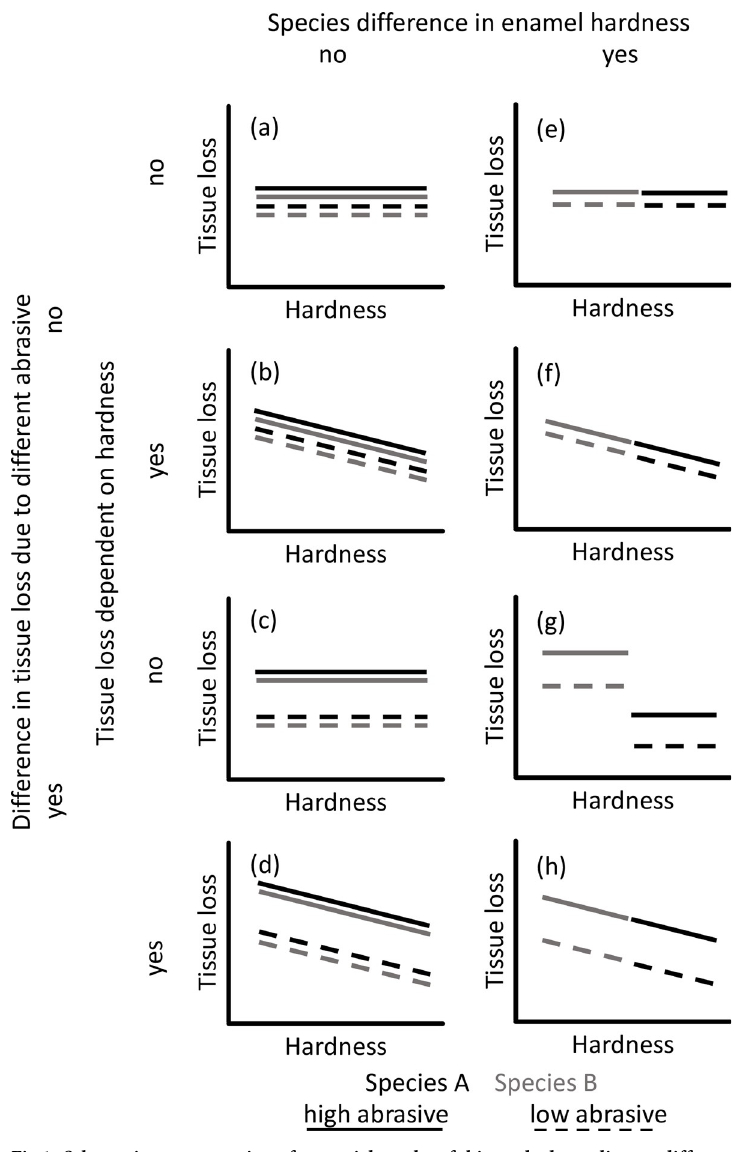
Fig 1. Schematic representation of potential results of this study depending on different combinations of whether species differ in enamel hardness (columns), and whether different abrasives lead to different tissue loss irrespective of, or in proportion to,